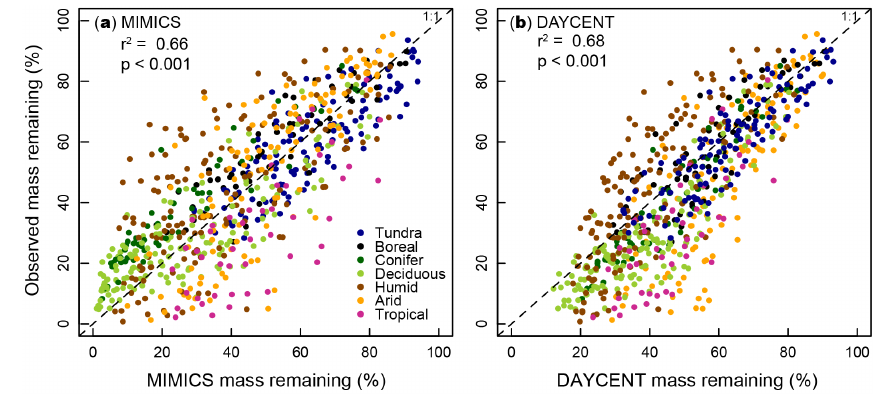
Figure 2. Litter decomposition results from observation and models. Points show the percent leaf litter mass remaining of six different litter types that decomposed over a decade-long experiment across 14 different LTER sites, which correspond to seven different biomes. Simulations from (a) MIMICS and (b) DAYCENT were sampled at the same time points as LIDET observations. Dashed line shows the 1 : 1 line (see also Table